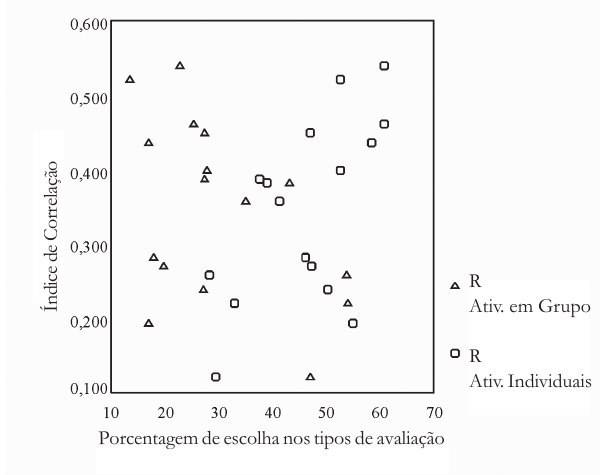
Figura 2. Dispersão dos índices de correlação entre o desempenho acadêmico e os escores do Cloze e as médias das porcentagens de escolha por tipo de avaliação